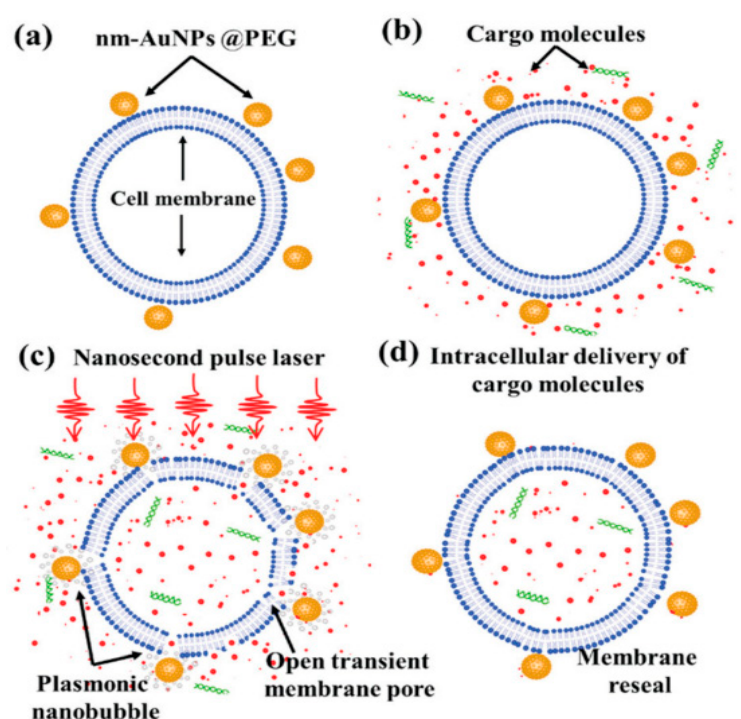
Figure 18. Schematic overview of photoporation procedure for intracellular delivery: ( a ) cells was incubated with PEG mediated nm-AuPNPs for attachment onto the cell membrane; ( b ) cargo molecules were added just before laser exposure; ( c ) nanosecond pulse laser-induced plasmonic nanobubbles formation at nm-AuPNPs and cell membrane interface resulting in transient pore formation; ( d ) successful intracellular delivery of cargo molecules with membrane reseal. Reprinted with permission from ref. [128]. Copyright © 2020 The Royal Society of Chemistry.